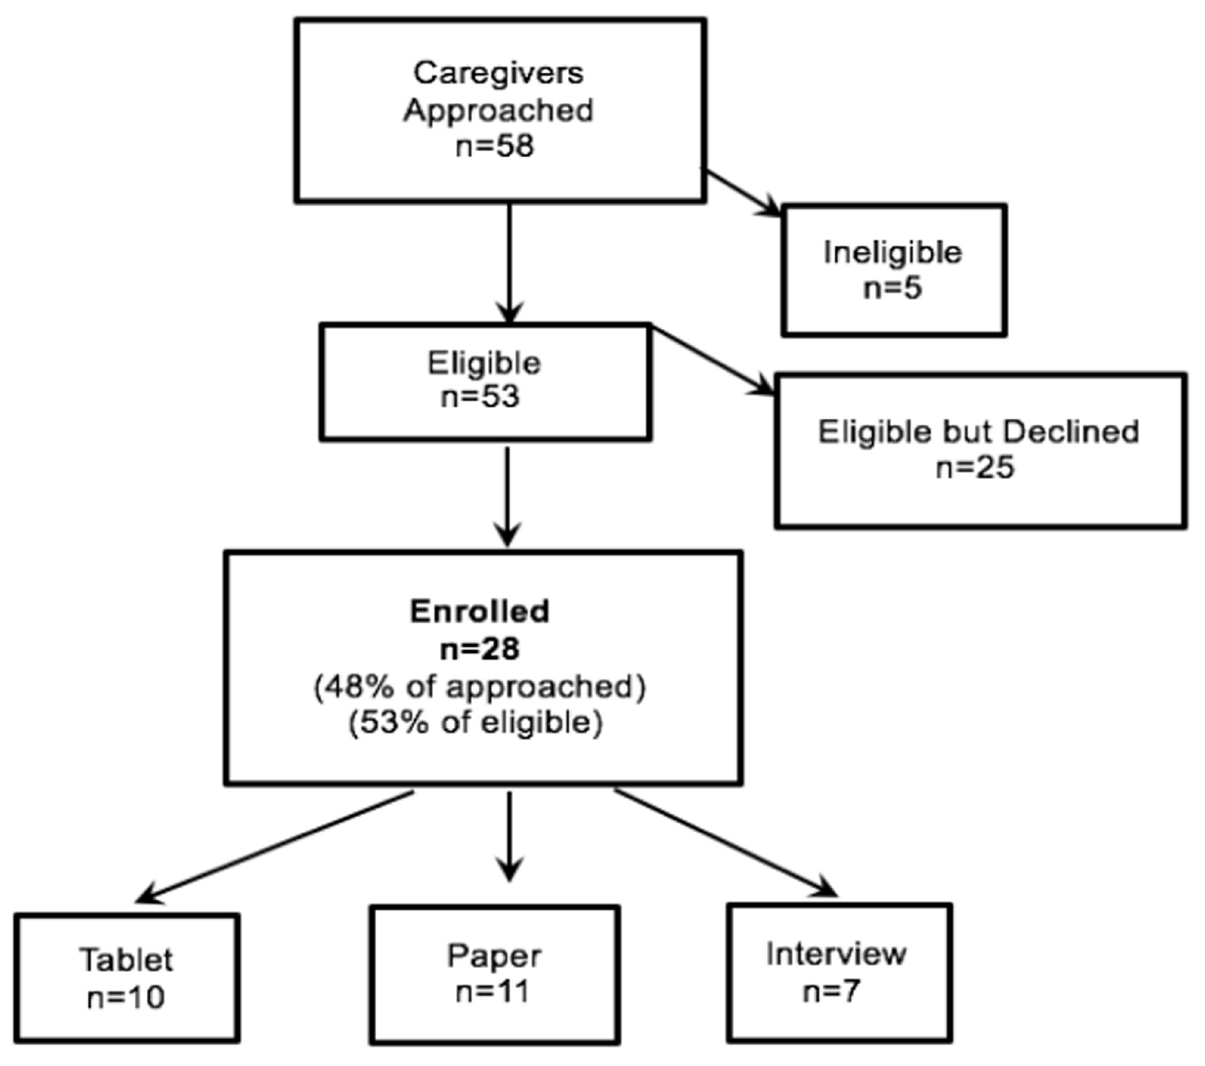
Fig 1. Consort diagram of study recruitment